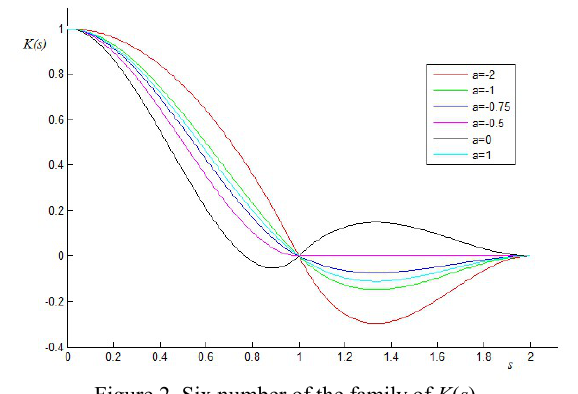
Figure 2. Six number of the family of K ( s ).